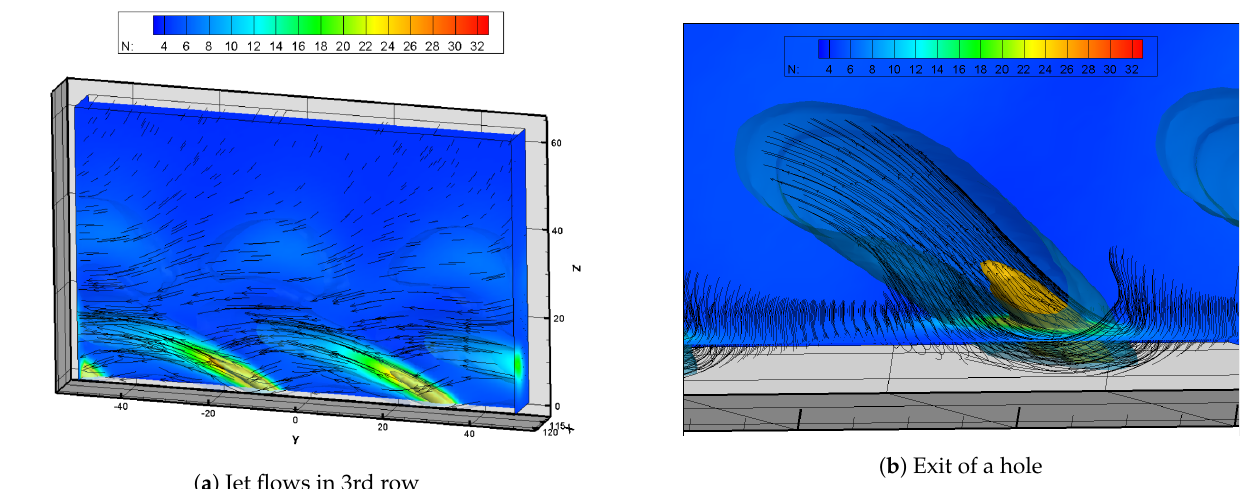
Figure 14. 3D reconstruction of the main flow on the 3rd row—The iso-surfaces are constructed for a velocity magnitude N equal to 5.7 m · s − 1